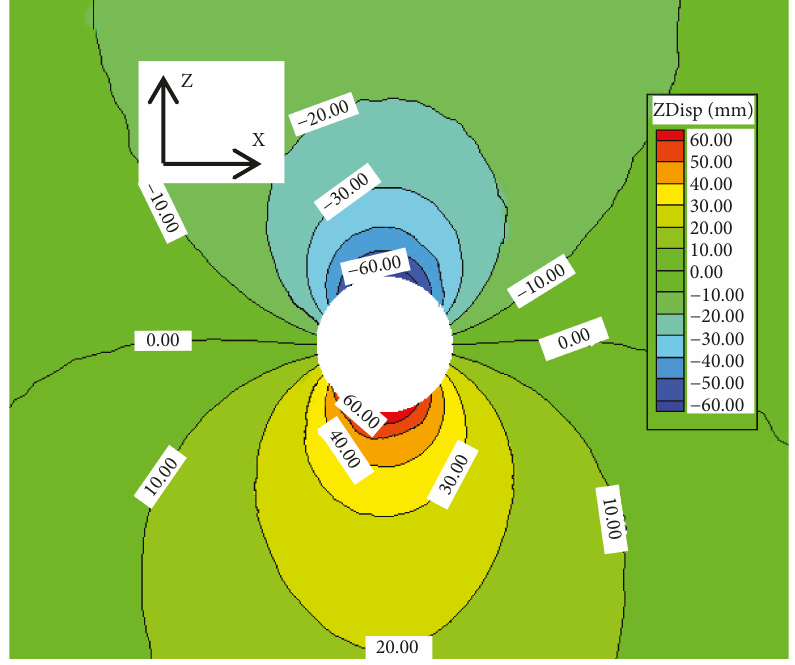
Figure 15: Displacement of section A-A along